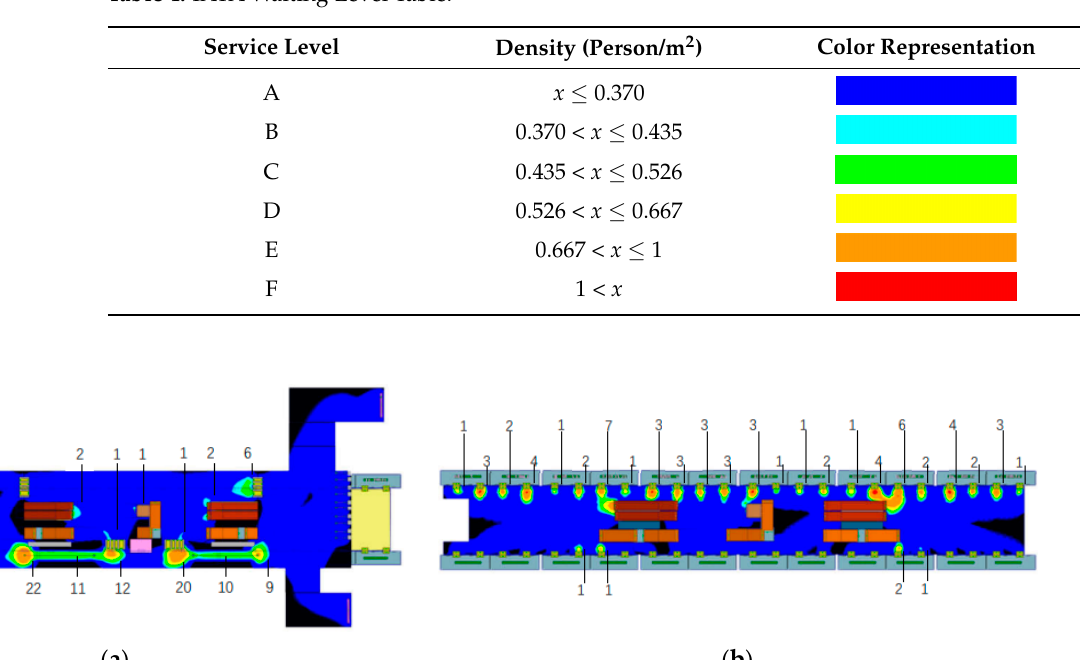
Table 4. IATA Waiting Level Table.